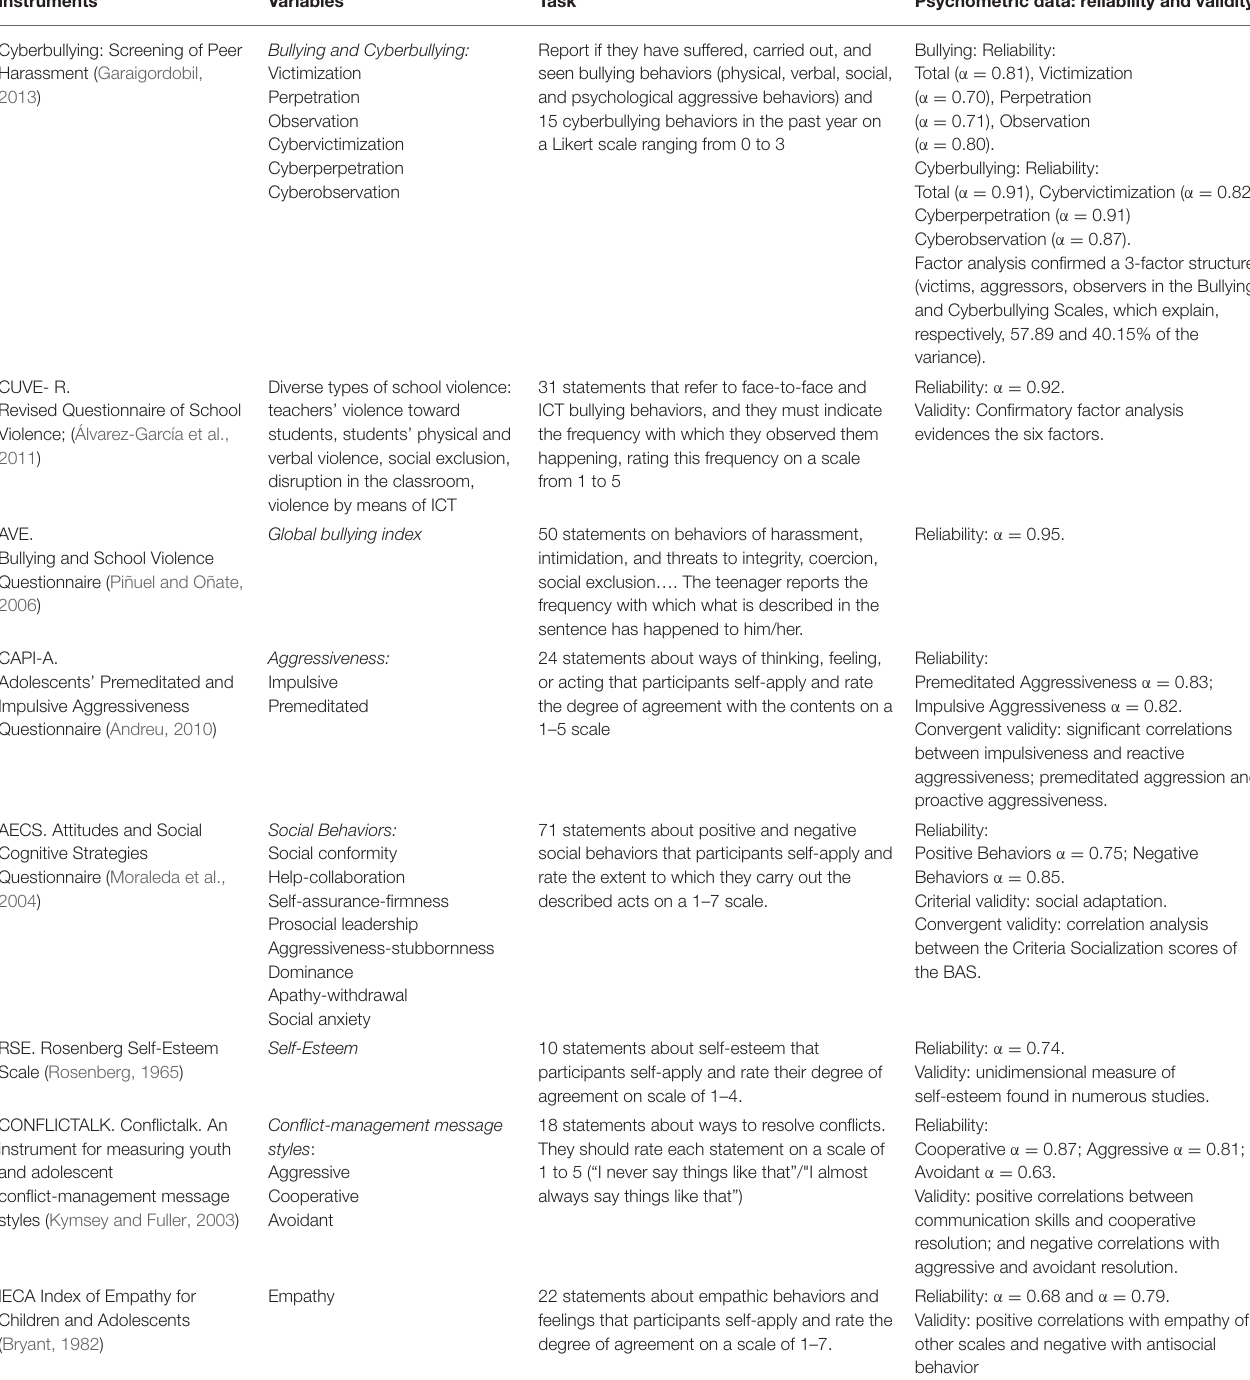
TABLE 2 | Pretest-posttest evaluation